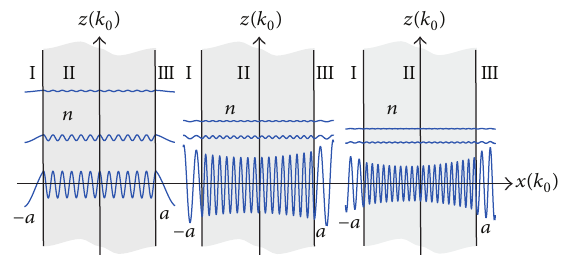
Figure 1: Propagation of resonances inside a slab waveguide of width 𝑘 0 𝑎 = 30 and constant refractive index 𝑛 = 𝑈 0 = 1.5 . The slab supports 17 leaky modes ( 24 ≤ 𝑚 ≤ 40 ) defined by (29). The figure shows the propagation in the axial direction (from the bottom to the top in each slab) of the real part of the leaky modes field amplitudes for 𝑚 = 24 (left), 𝑚 = 32 (center), and 𝑚 = 40 (right). Note that these are attenuated as the mode propagates. The leakage is faster for larger values of 𝑚